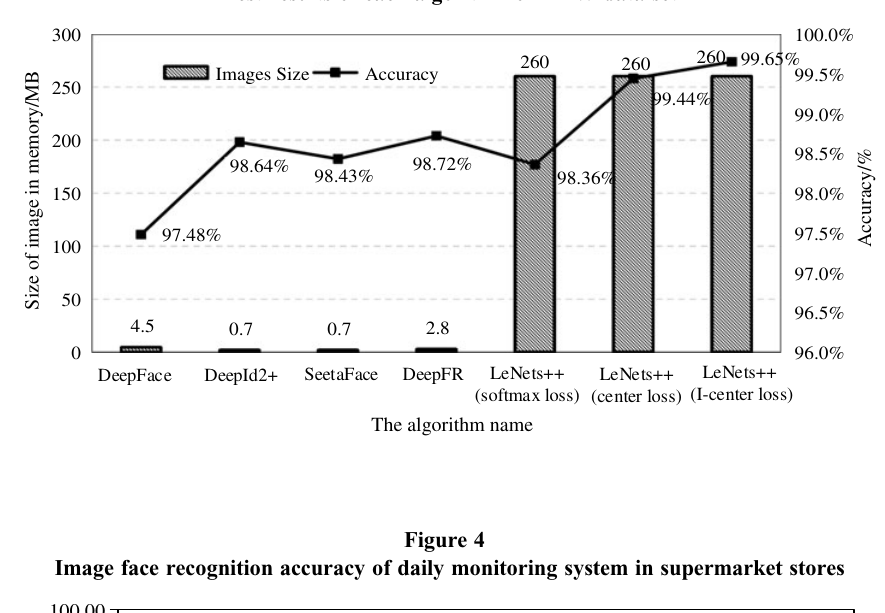
Test results of each algorithm on LFW data